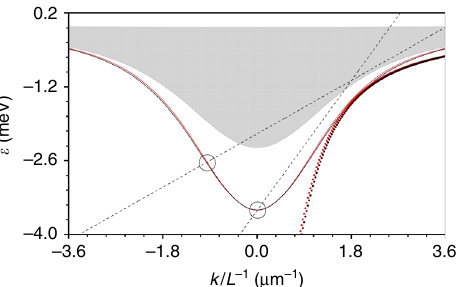
Fig. 3 Soliton branches and soliton pro fi les. a Soliton amplitudes for the TM (thin dash-dotted line), TE (blue dashed line) and σ ± (solid red and black lines) families vs. the energy offset ε = δ ħ Ω R for v = 0.15, k s = 1.5, β = 0.02. The linear TE-TM energy splitting, 20 μ eV, can be seen at b + = 0, which is consistent with the experimental data (Supplementary Figs. 1 and 2). b Spatial pro fi les of the photonic (solid lines) and excitonic (dashed lines) components of the σ + soliton for ϵ = − 1.305 meV ( δ = − 0.29). Black lines in b show b + , φ + , while red lines show b − , φ resulting linear eigenvalue problem for a ± ( y , k ), ψ ′ ± ( y , k ) and δ ( k ) is solved numerically. Figure 2 shows the corresponding energy vs. momentum (dispersion) plot for the MCW ground-state modes. Degeneracy between the TE and TM modes within the pairs is lifted through β ≠ 0. The effective polariton mass of the ground states m (cid:4) (cid:5) ε (cid:1) h = Ω 2 ∂ 2 R L k